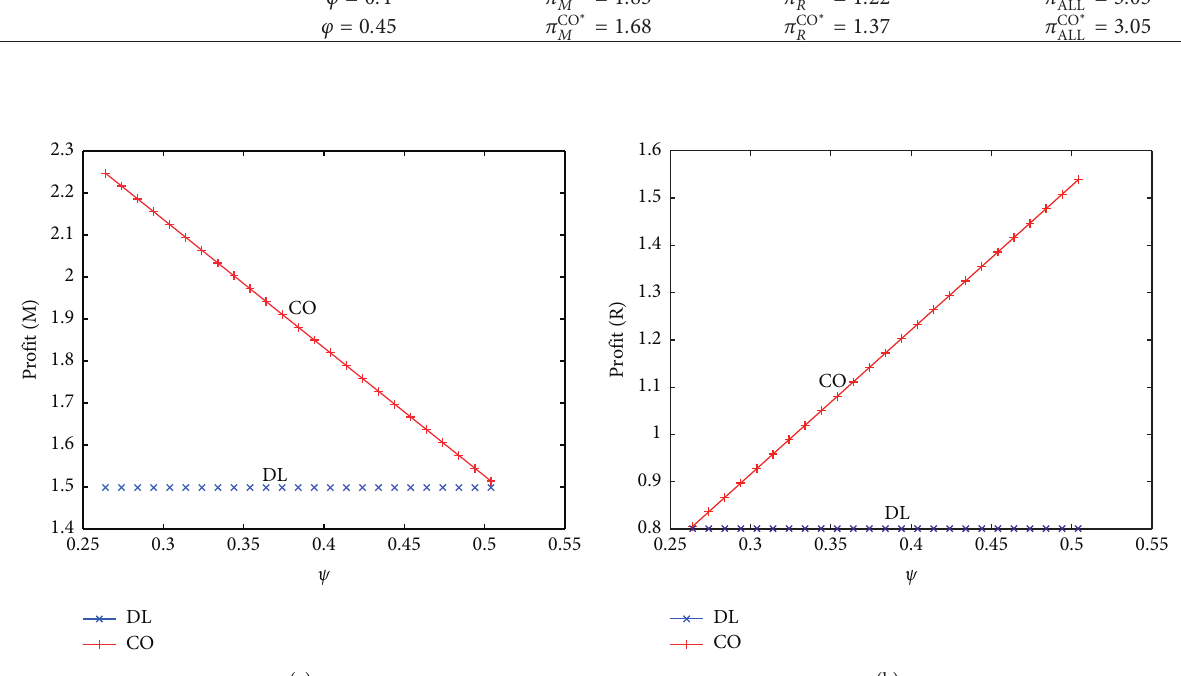
Figure 5: The impact of different contract parameters on supply chain profits under the revenue-sharing mechanism: (a) manufacturers’ profits and (b) retailers’